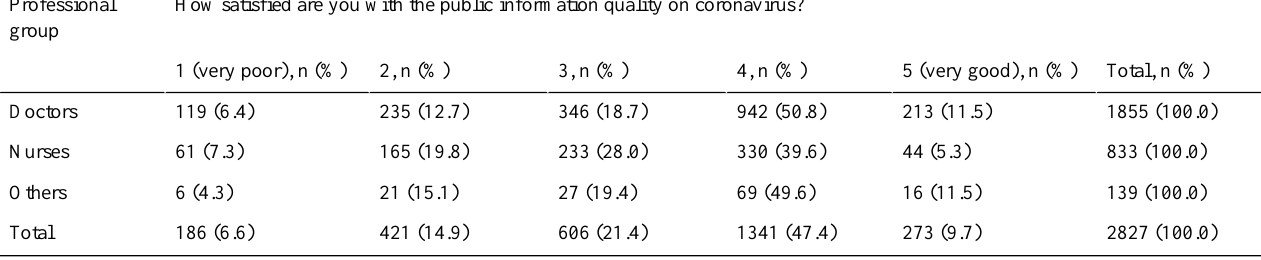
Table 5. Perception of the information quality on the coronavirus among professional groups. How satisfied are you with the public information quality on coronavirus?Professional